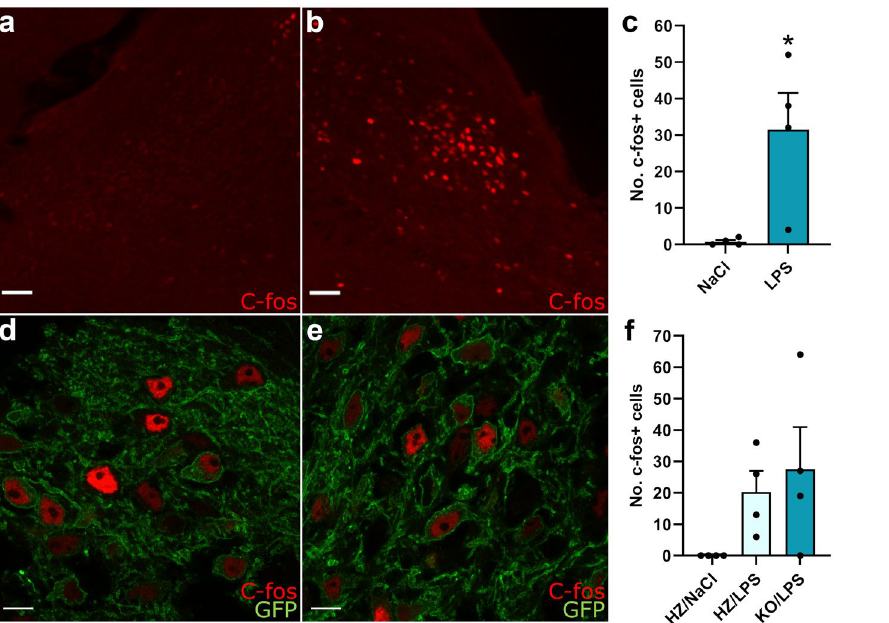
Figure 2. C-fos expression in the PBN after LPS-injection. ( a , b ) Representative fluorescent images showing c-fos immunoreactivity in the PBN of one NaCl ( a ) and one LPS ( b ) injected WT animal. Scale bar 50 µm. ( c ) The amount of C-fos positive cells in the PBN is higher 3 h after LPS injection i.p. compared to 3 h after NaCl injection in WT animals (T-test: p = 0.02, NaCl n = 4, LPS n = 4). ( d , e ) Representative confocal images of the PBN showing c-fos expression (red) in CGRP-neurons expressing GFP (green) from one Hz ( d ) and one KO ( e ) animal. Scale bar 10 µm. ( f ) LPS induced c-fos expression in both Hz and KO mice (Hz/NaCl n = 4, Hz/LPS n = 4, KO/LPS n =